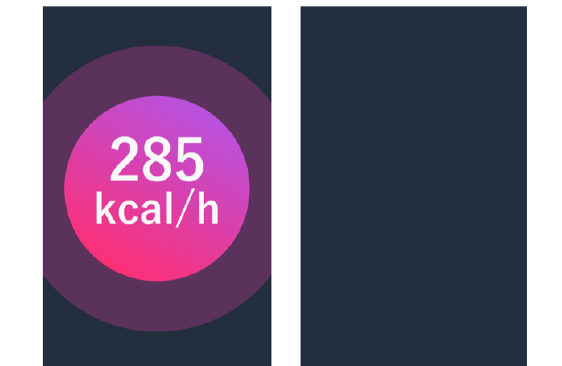
Figure. 8. The status of the independent variable in the experiment scenario (left) and control scenario (right).